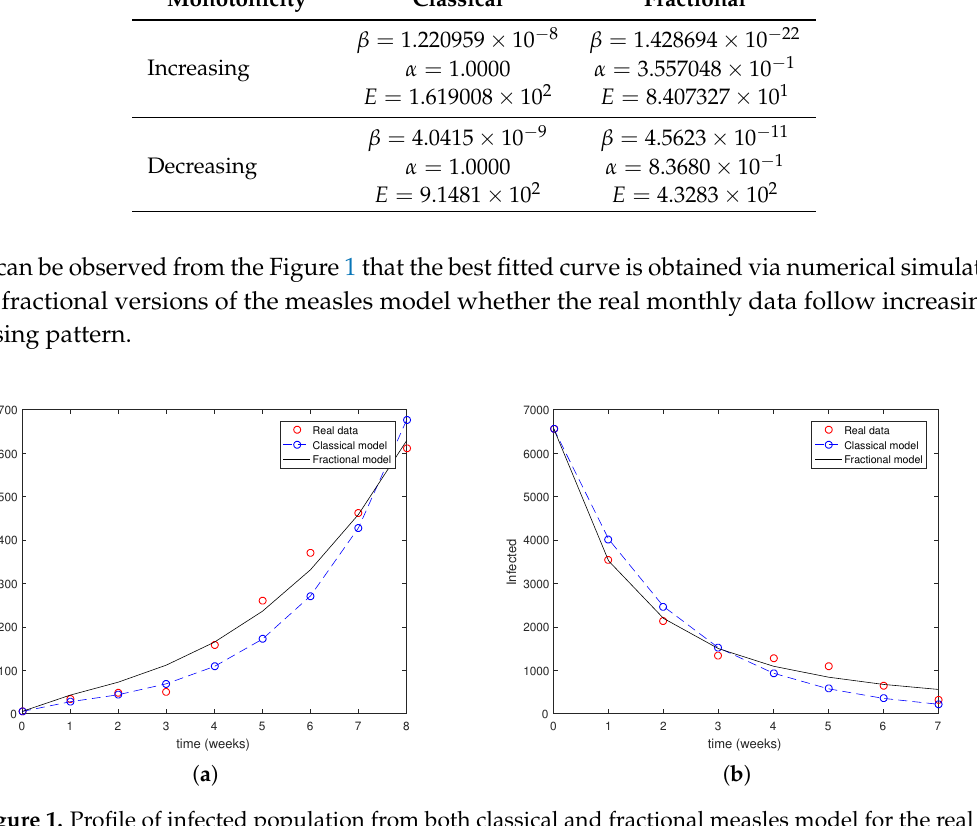
Figure 1. Profile of infected population from both classical and fractional measles model for the real monthly data with monotonically increasing ( a ) and decreasing ( b )